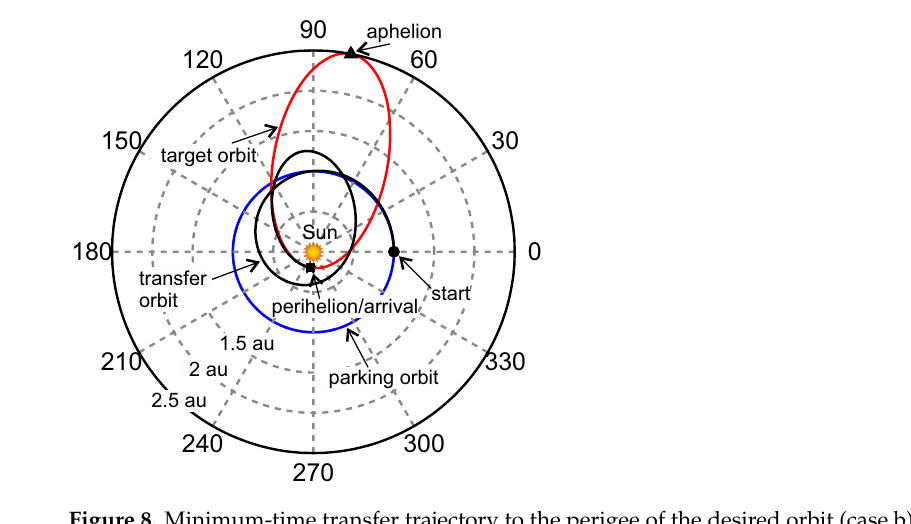
Figure 8. Minimum-time transfer trajectory to the perigee of the desired orbit (case b).